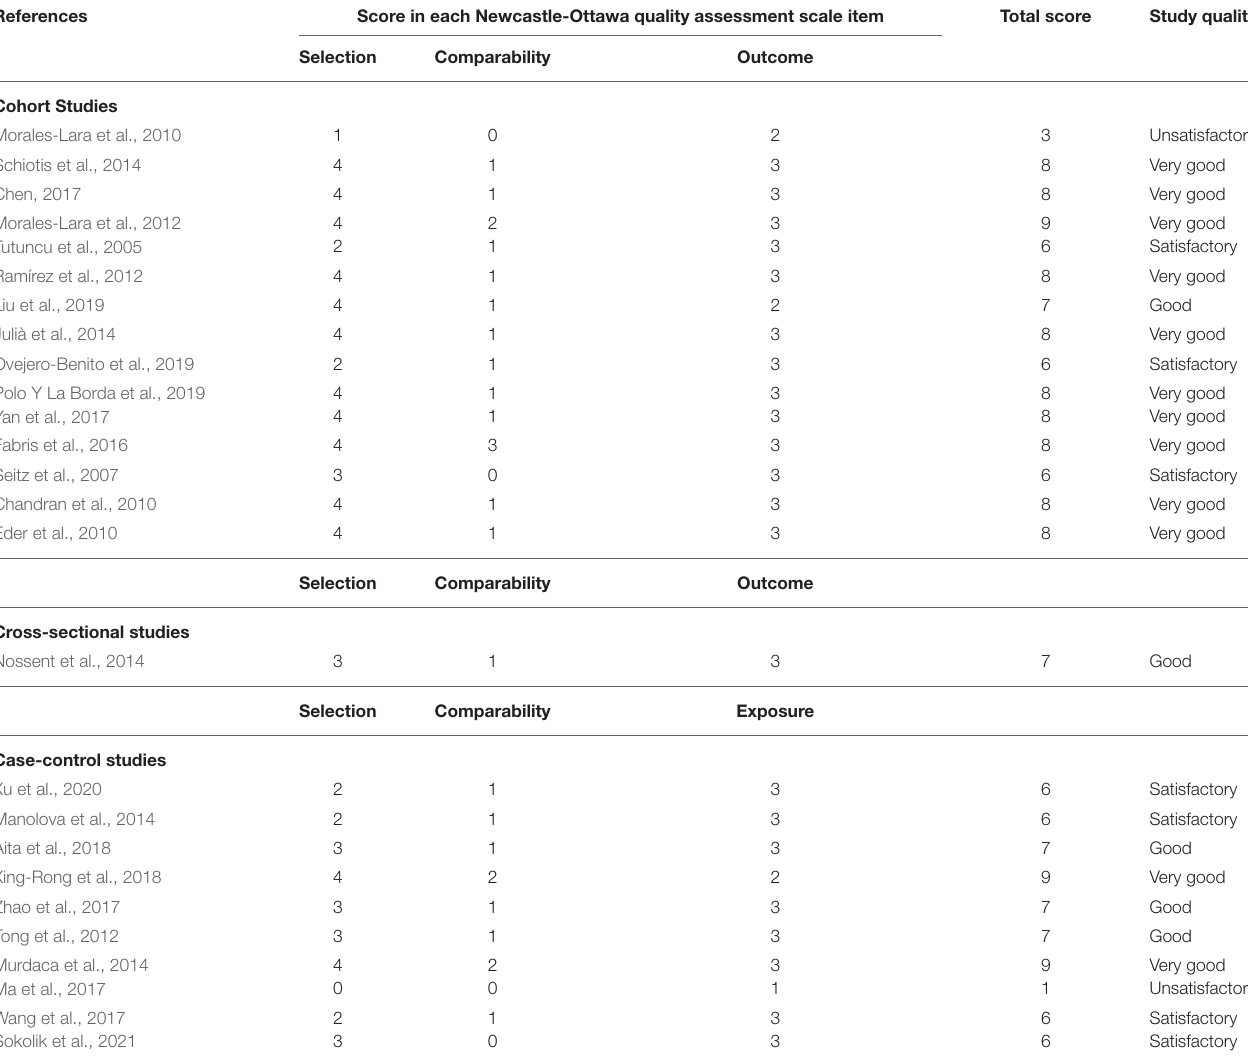
TABLE 2 | Application of Newcastle-Ottawa quality assessment scale (NOS) for cohort, cross-sectional and case control